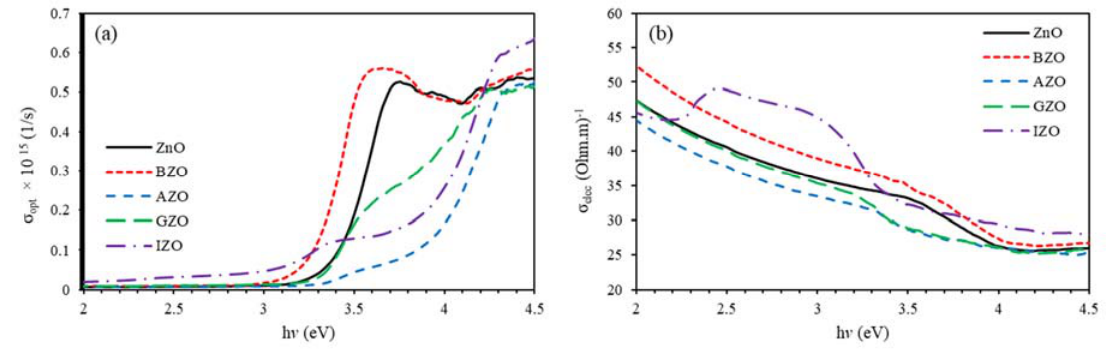
Figure 3. ( a ) The variation of the optical conductivity with the photon energy, and ( b ) the variation of the electrical conductivity with the photon energy of undoped ZnO and group III elements (B, Al, Ga, and In) ‐ doped ZnO thin films at 3% doping concentration.